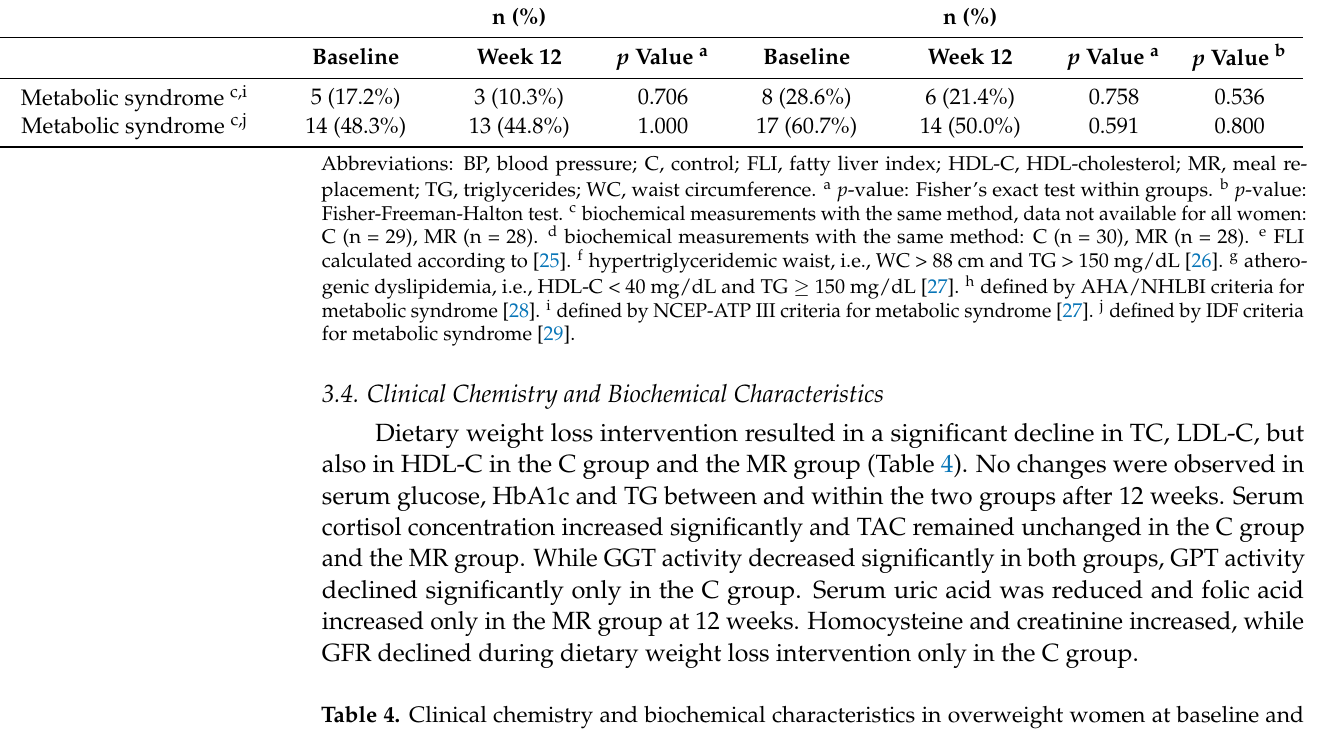
Table 4. Clinical chemistry and biochemical characteristics in overweight women at baseline and after dietary